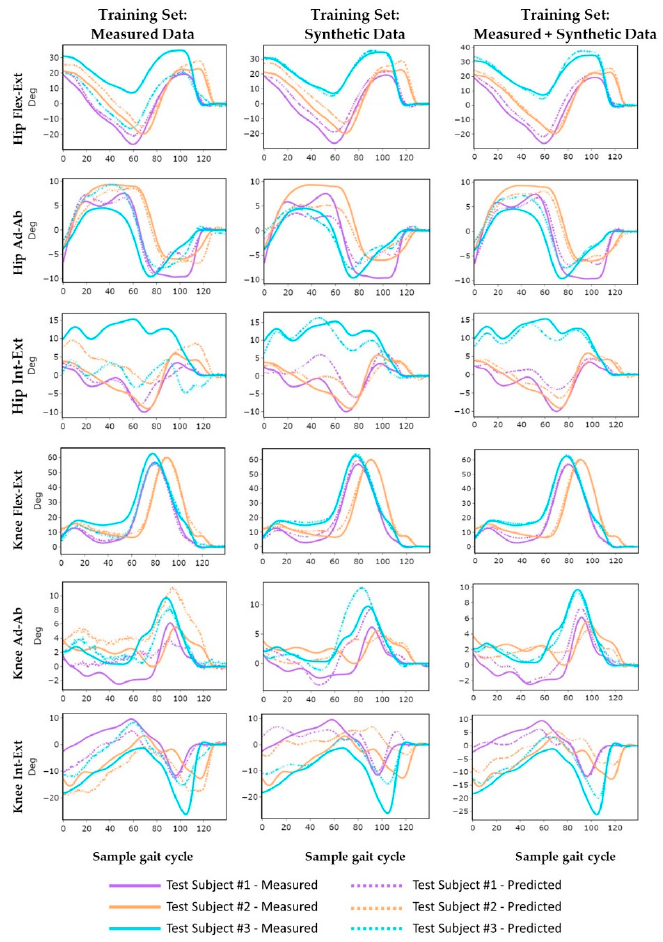
Figure 5. Measured and predicted lower limb kinematics in each degree of freedom during an exemplary trial for each test subject during gait: prediction (dashed line) and measured (solid line) for different training datasets.